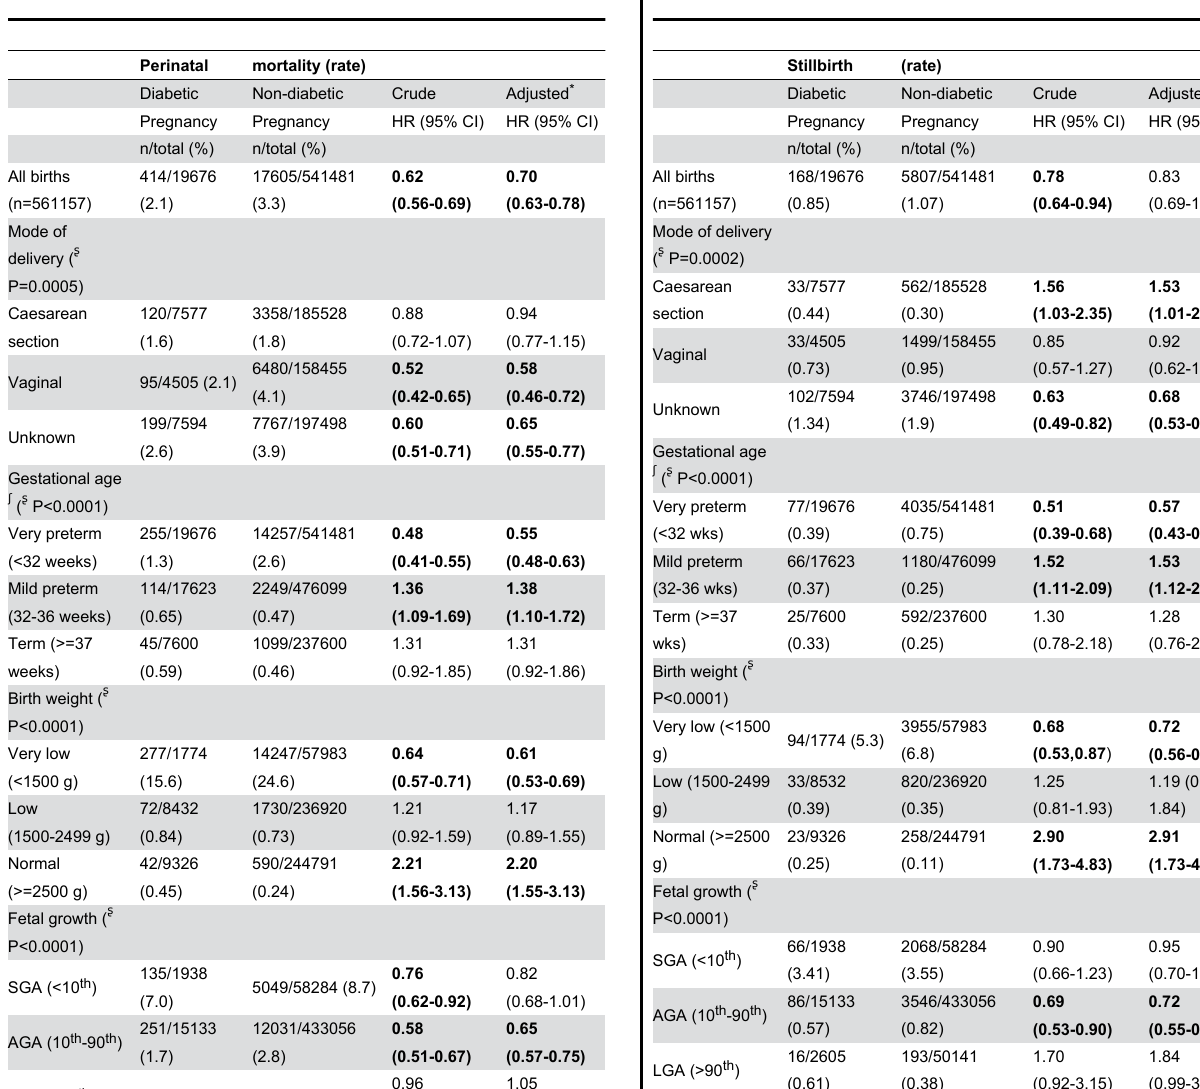
Table 2. Perinatal mortality in diabetic versus non-diabetic twin pregnancies, U.S. matched multiple birth data 1995-2000 [16].